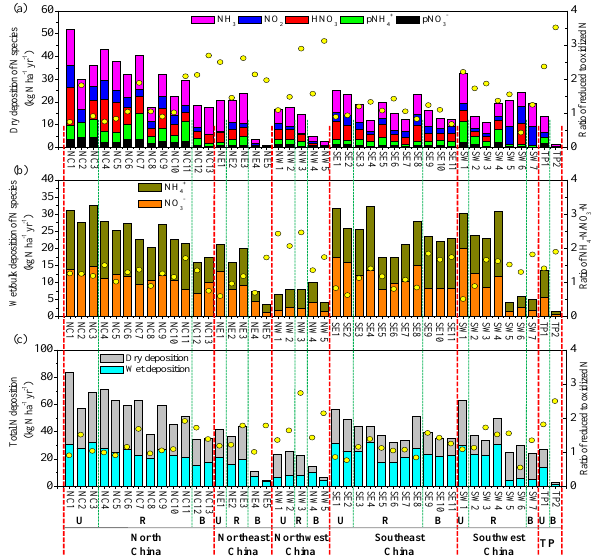
Figure 5. Annual deposition flux of various N r species at the 43 selected sites in China: (a) dry deposition flux; (b) wet/bulk depo- sition flux; (c) total deposition flux. Yellow dots denote ratios of reduced N to oxidized N in dry deposition (a) , NH + –N to NO − –N 4 3 in wet/bulk deposition (b) and/or reduced N to oxidized N in total deposition (c) at all sampling sites. U, R, and B denote urban, rural, and background sites, respectively. TP denotes the Tibetan